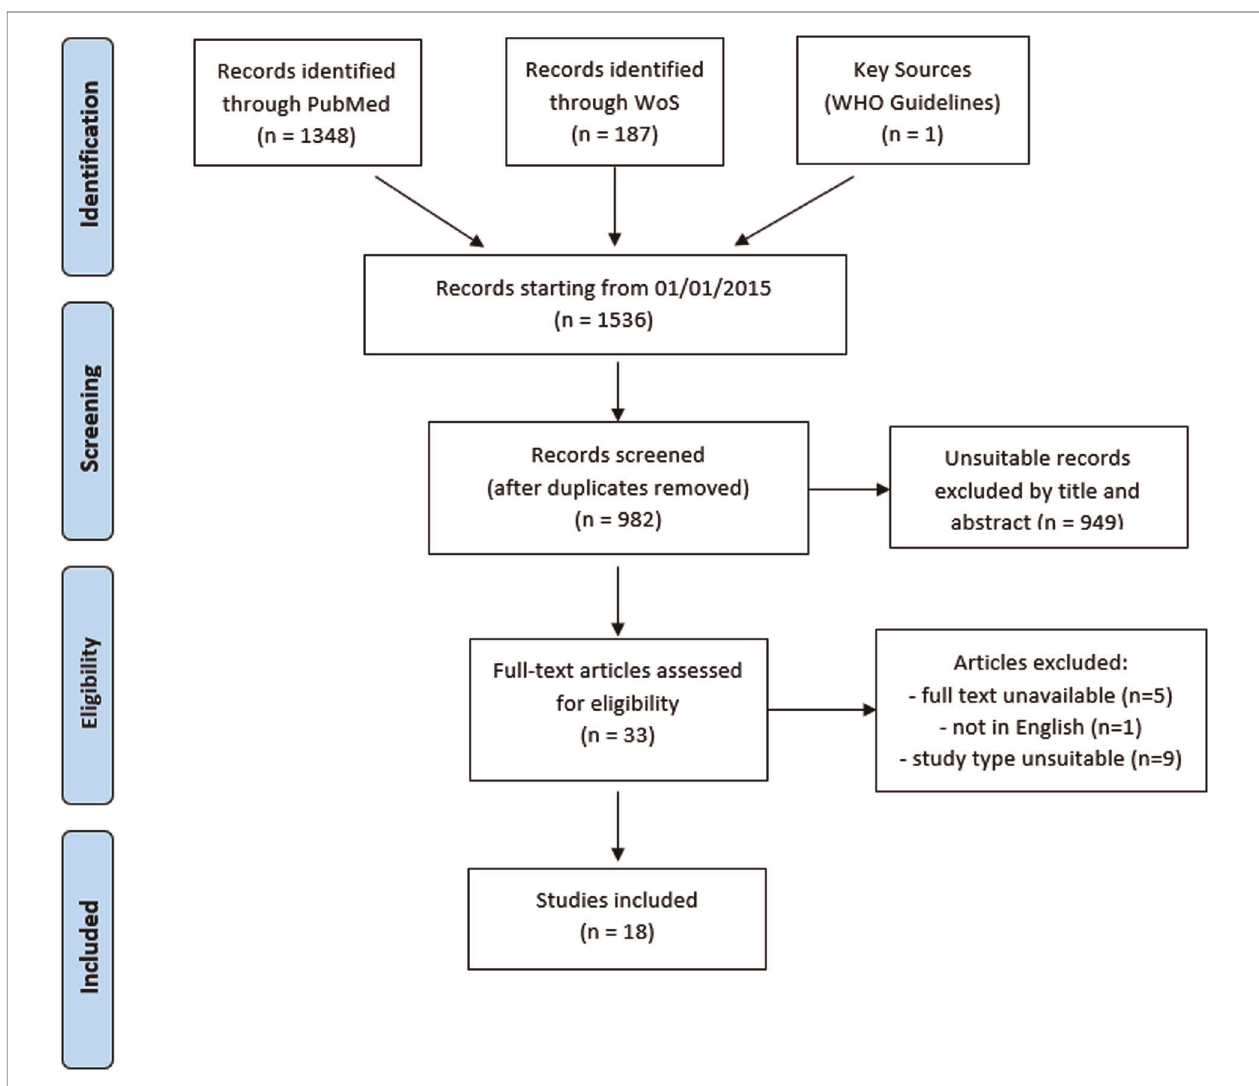
FIGURE 1 | PRISMA fl ow